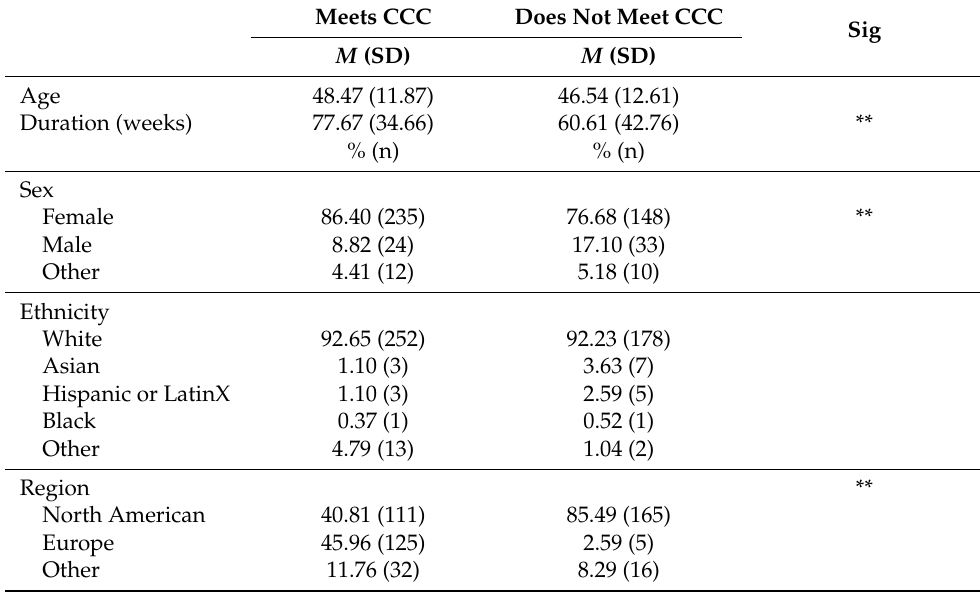
Table 1. Demographic information across the two groups of those who meet CCC criteria and those who do not meet CCC